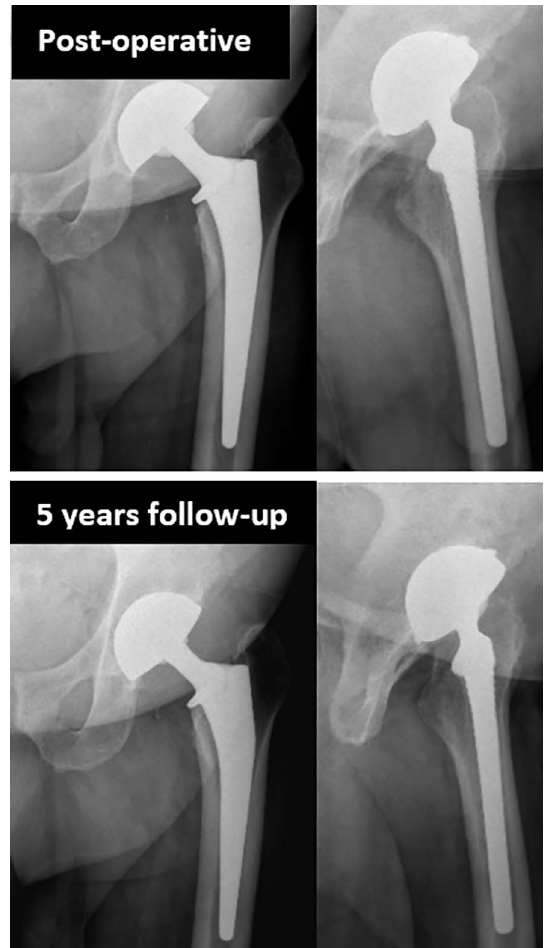
Figure 5. No eccentric position of the femoral head in the cup (as a sign of polyethylene wear) was found at the last